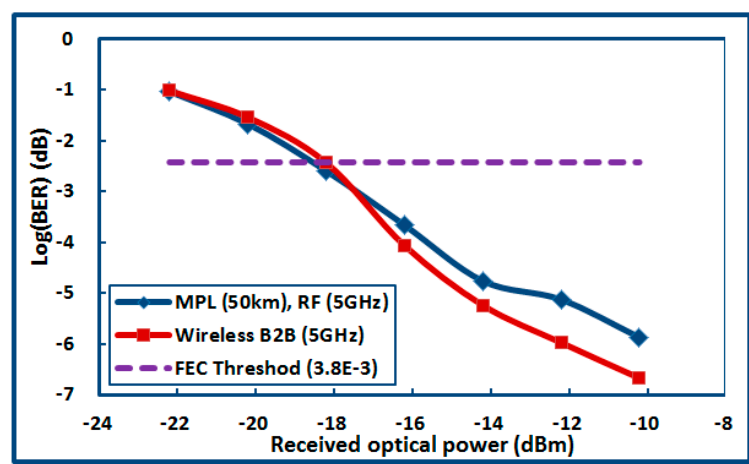
Figure 18. Transmission performances of the radio frequency (RF) carrier with 5